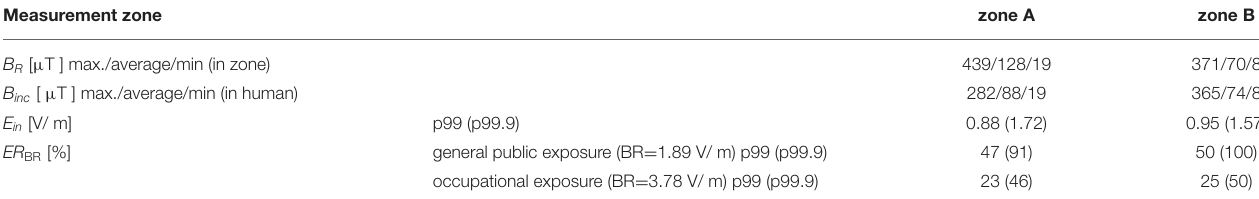
TABLE 4 | Comparison of exposures in human bodies standing in the aisle (zone A) and beside the gatepost (zone B) of EAS gate G2. Measurement zone